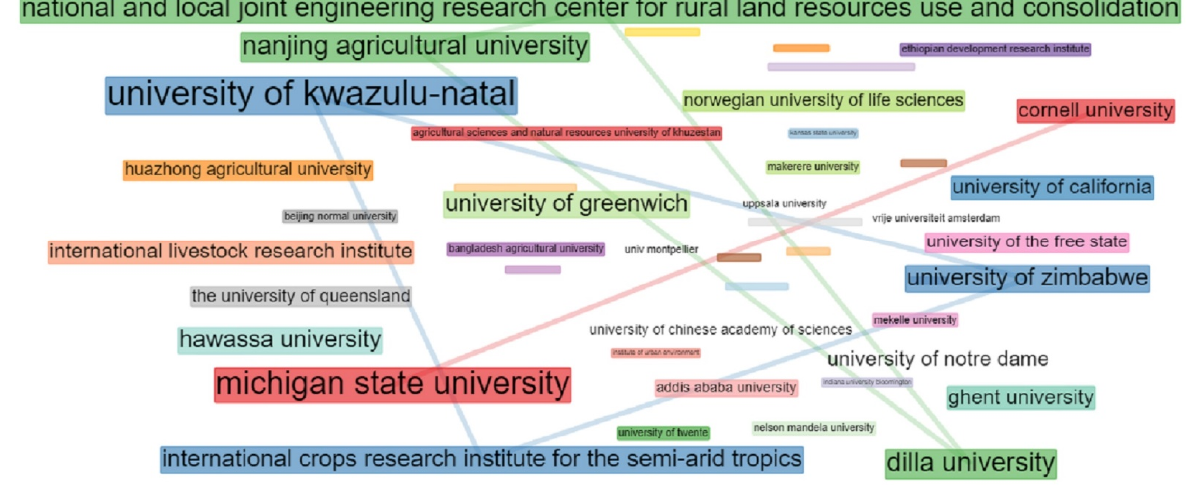
Figure 6 . Collaboration network for the top 50 authors in PASSFDR studies indexed in Scopus from